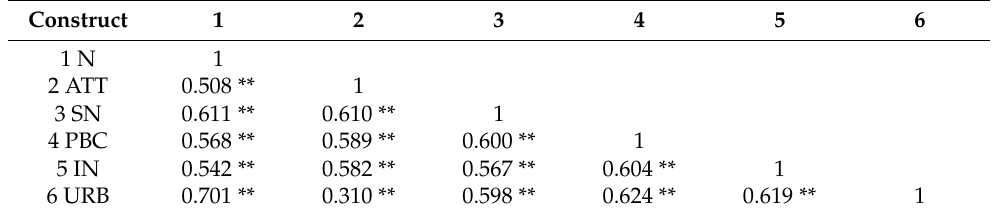
Table 3. Extended TPB model bivariate correlation